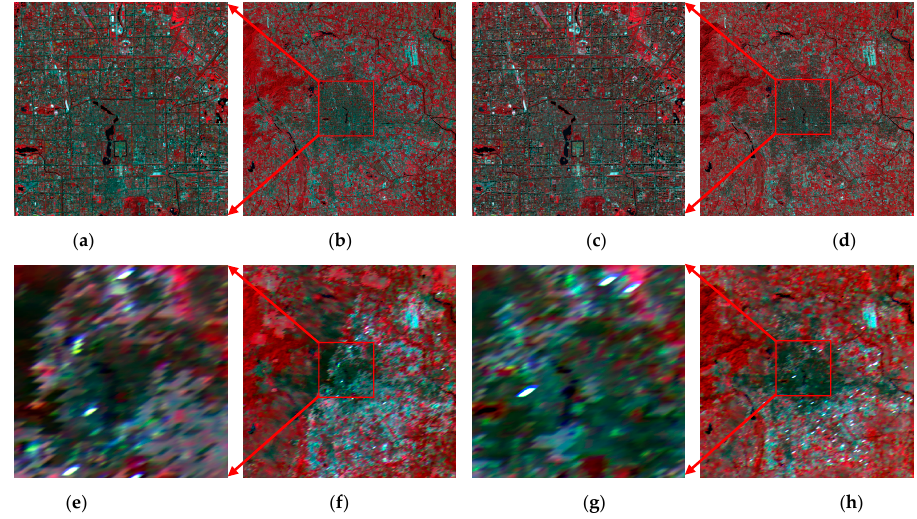
Figure 3. Landsat and MODIS reflectance data (NIR/red/green) that cover the Beijing urban area:( a ‒ d ) Landsat-8 images observed on 10 July and 12 September 2017 with a size of 500 × 500 and 2000 × 2000 pixels; ( e ‒ h ) MODIS reflectance products that correspond to ( a–d ).